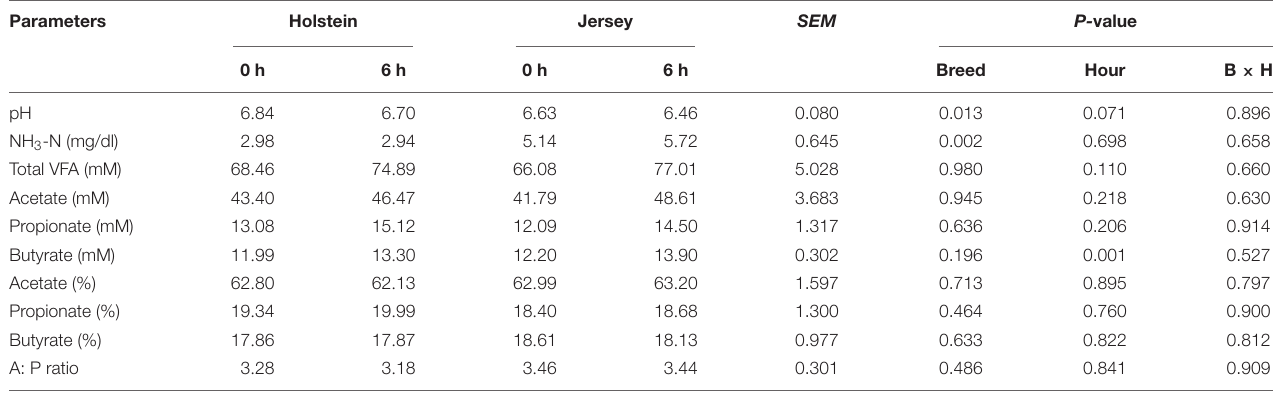
TABLE 3 | Rumen fermentation characteristics of Holstein and Jersey steers. Parameters Holstein Jersey